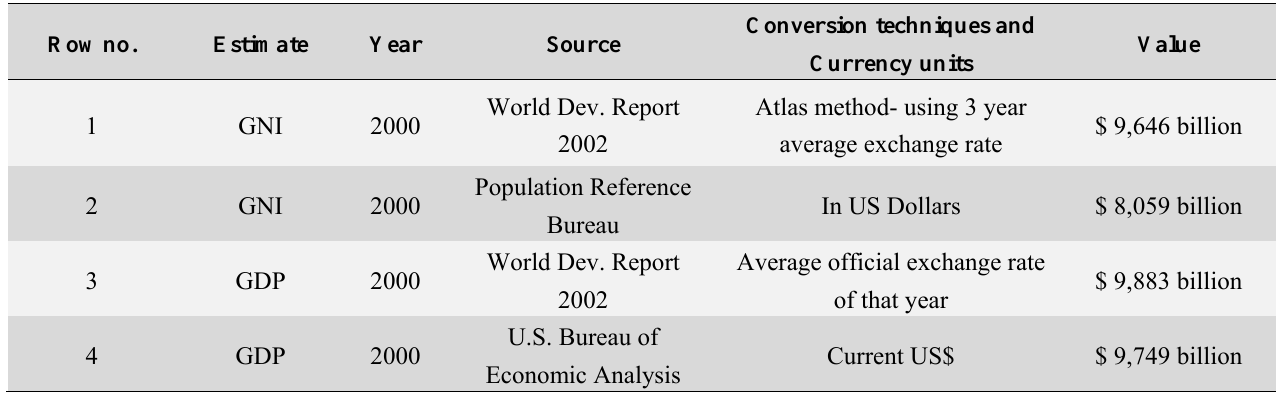
Table 1. Comparison of the GNI and GDP estimates of the United States from different sources. Row no. Estimate Year Source